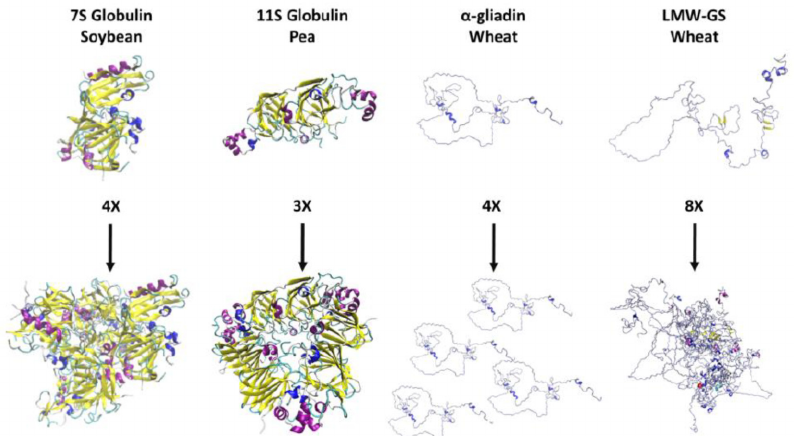
Figure 1. Single subunits and polymers obtained from these, of (left to right): The storage proteins 7S globulin in soybean, 11S globulin in pea, a-gliadin in wheat, and low molecular weight glutenin subunits (LMW-GS) in wheat. Amino acid sequences and simulation tools applied to determine the structures are described in Yoshizawa et al. [107] and Research Collaboratory for Structural Bioinformatics Protein Data Bank (RCSB PDB) (3AUP) [39] for 7S globulin, and in Tandang-Silvas et al. [108] and RSCB PDB (3KSC) [39] for 11S globulin. Amino acids sequences for a-gliadin and LMW-GS can be found at Uniprot accession numbers Q9ZP09 and P10386 and simulation was carried out using an all-atom model with Monte Carlo algorithms in the program Profasi [126]. All models were visualized using Visual Molecular Dynamics